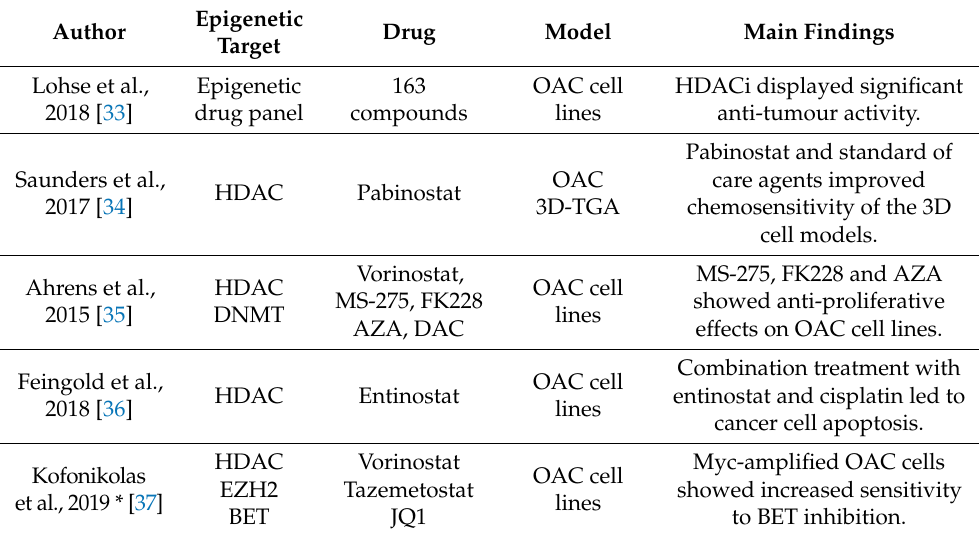
Table 1. Key findings of pre-clinical studies using HME therapies in oesophageal